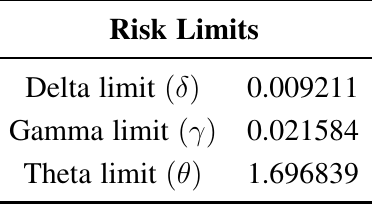
Table 3. Portfolio risk